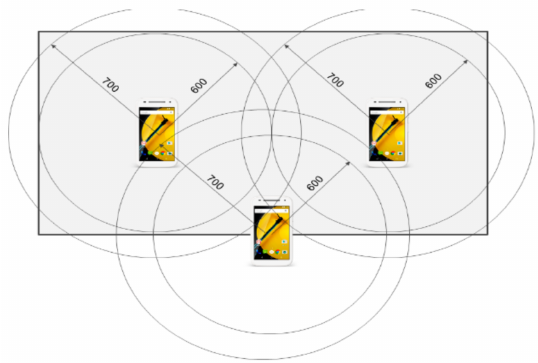
Figure 3. The positions of base stations in den and feeding